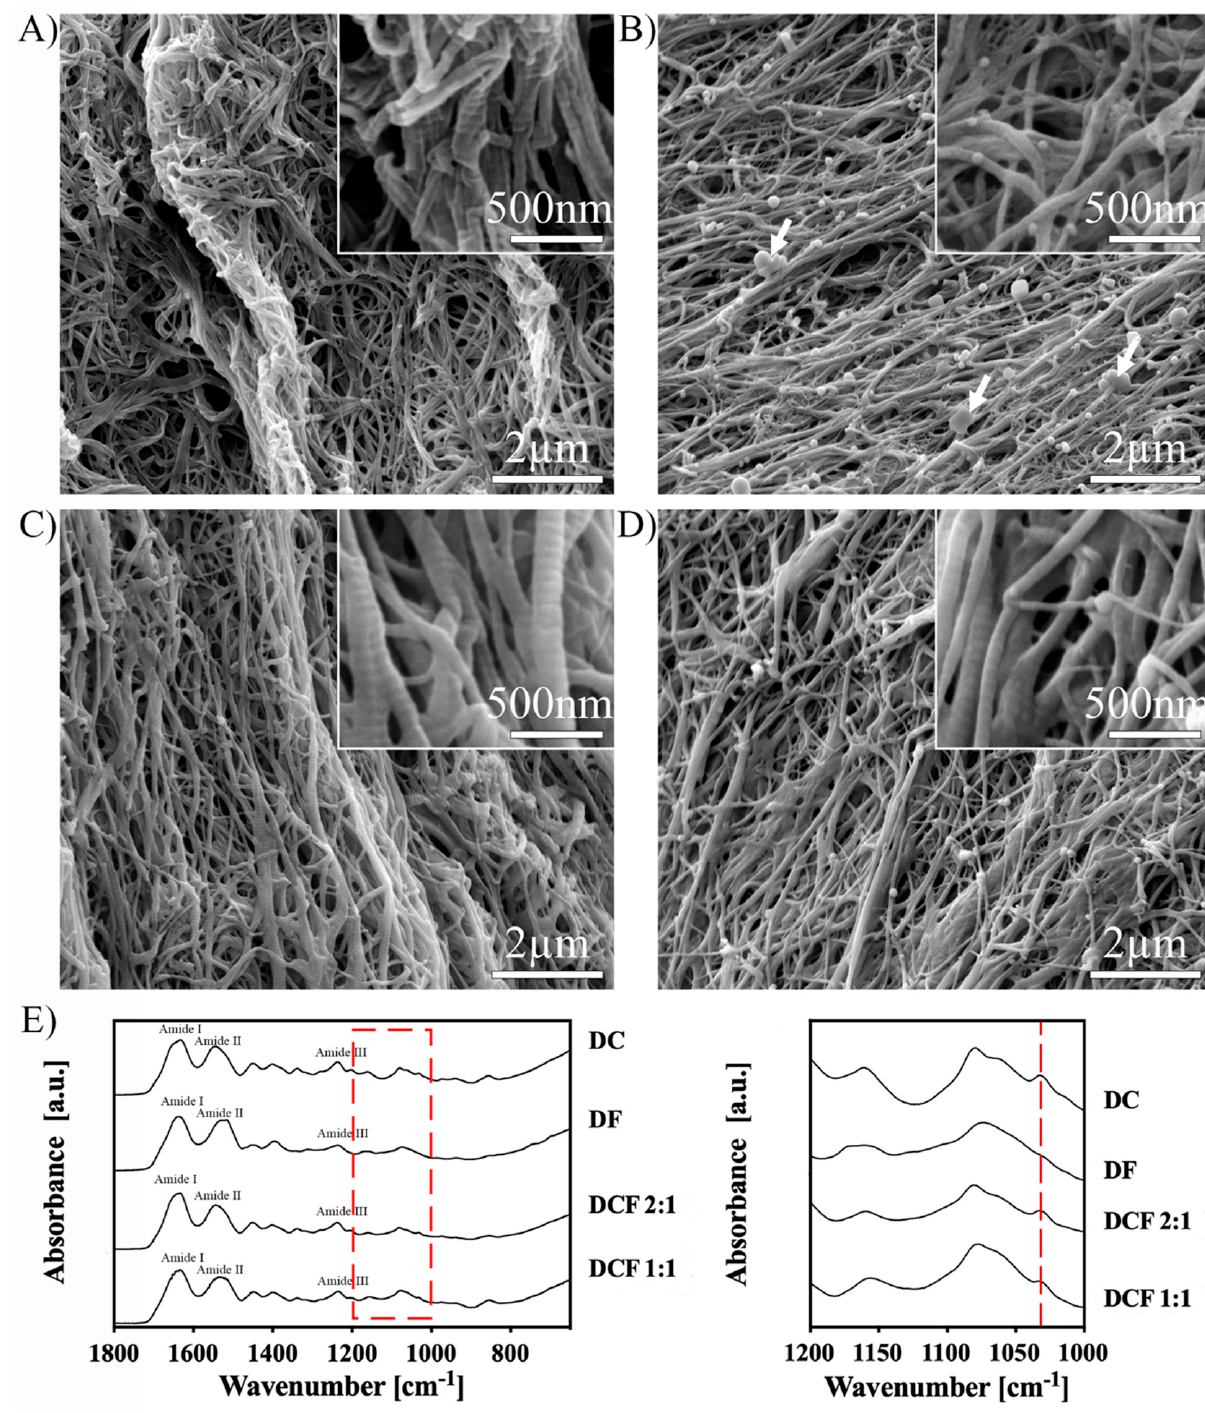
Figure 1. Characterization of as-made GAE-generated DC, DF, and DCF gels. SEM micrographs of ( A ) DC gels demonstrating the typical d -banding (inset) of type I collagen fibrils, ( B ) DF gels demonstrating a combination of smooth fibres and clots, ( C ) DCF 2:1, and ( D ) DCF 1:1 hybrid gels showing entanglements of both fibrous types. Insets showing higher magnification images. ( E ) Left panel: ATR-FTIR spectra of as-made DC, DF, and DCF gels. Spectra of DCF gels appeared similar to those of DC gels. Right panel: expansion of the area indicated by the red dashed rectangle in the left panel. The intensity of the absorption band at 1035 cm − 1 (red dashed line) observed in the spectrum of DC gels was absent in that of DF gels and decreased with increasing fibrin content in the hybrid gels (right).